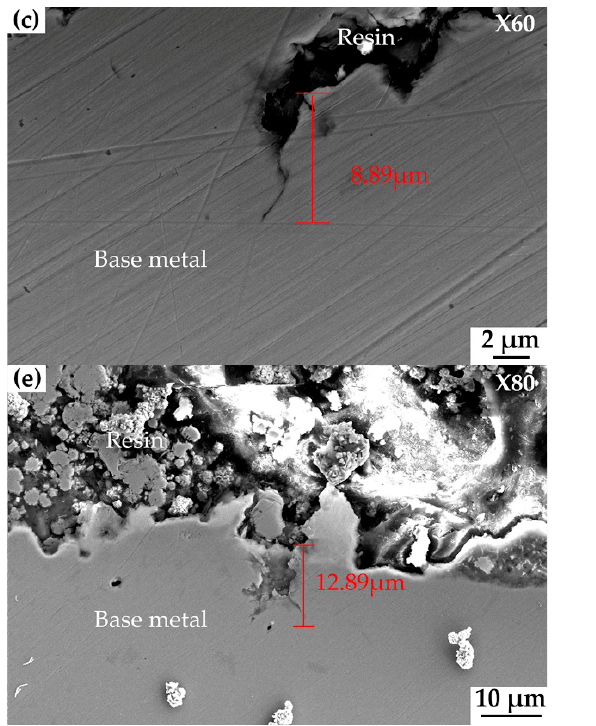
Figure 10. The crack growth morphology at different positions on the cross-section 20#, X60 and X80 pipeline steels after SSRT to the UTS level for 48 h: middle section: ( a , c , e ), lateral section: ( b , d , f ). From the stress-strain measurements of the 20#, X60, and X80 steels, the time interval for the load to pass the threshold level and the final maximum UTS point was calculated